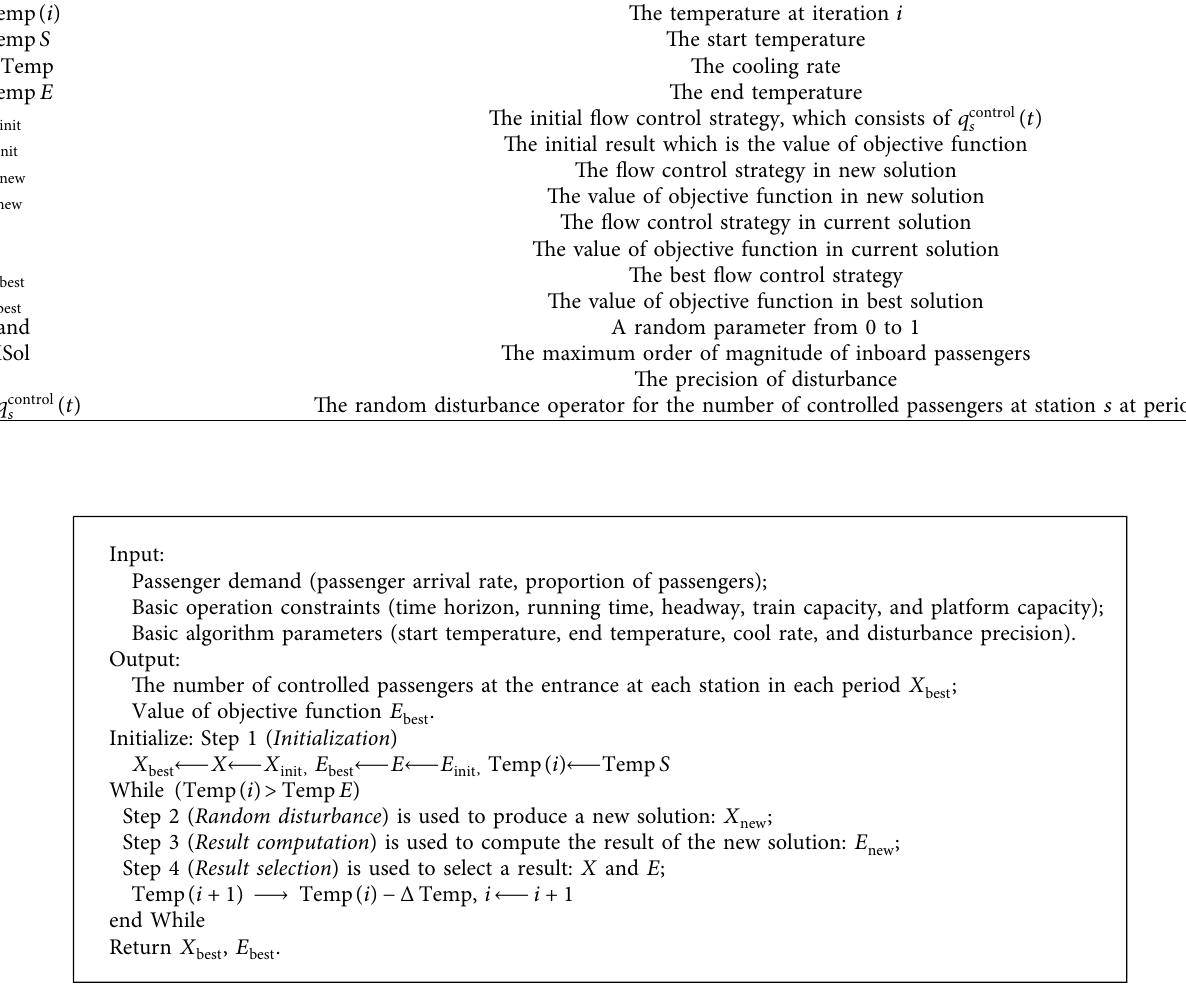
A LGORITHM 1: Improved simulated annealing